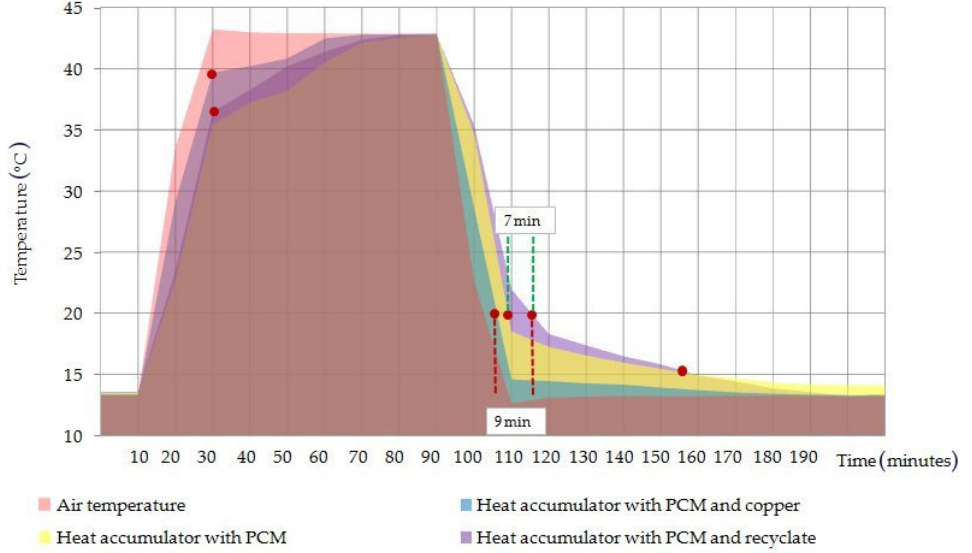
Figure 8. Temperature distribution chart of the heat accumulator test specimens operating in parallel in the climate test chamber.